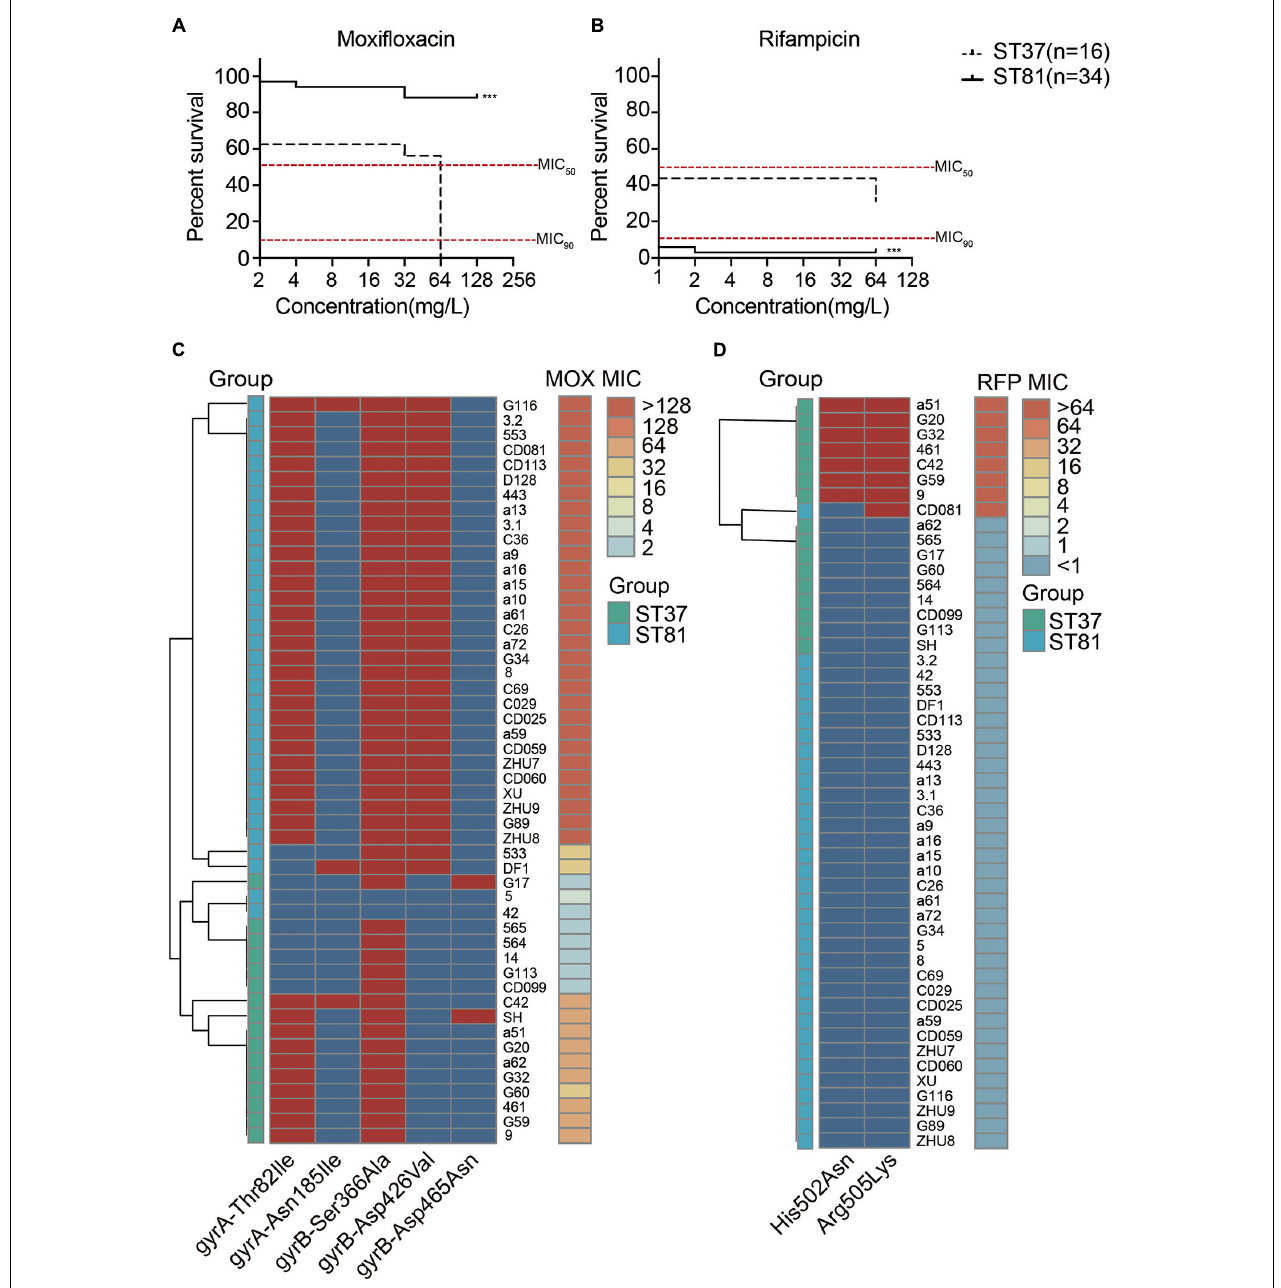
FIGURE 5 | Antimicrobial susceptibility and amino acid substitutions in the moxifloxacin and rifampicin resistance genes. (A,B) Survival curves of isolates under various concentrations of moxifloxacin (A) and rifampicin (B) . MIC 50 and MIC 90 are indicated with red lines. The ST81 and ST37 isolates are indicated with solid and dashed lines, respectively. Significant differences are indicated with *** p < 0 . 001. (C,D) Mutations of resistance genes associated with the MIC values toward moxifloxacin (C) and rifampicin (D) for each of the clinical isolates. The MIC values are shown on the right vertical axes and marked in colors from light blue to orange. The presence (red) and absence (blue) of mutations indicated on the horizontal axes were in the middle part. Isolates genotyped as ST81 and ST37 are indicated in light blue and light green, respectively. MOX, moxifloxacin. RFP,